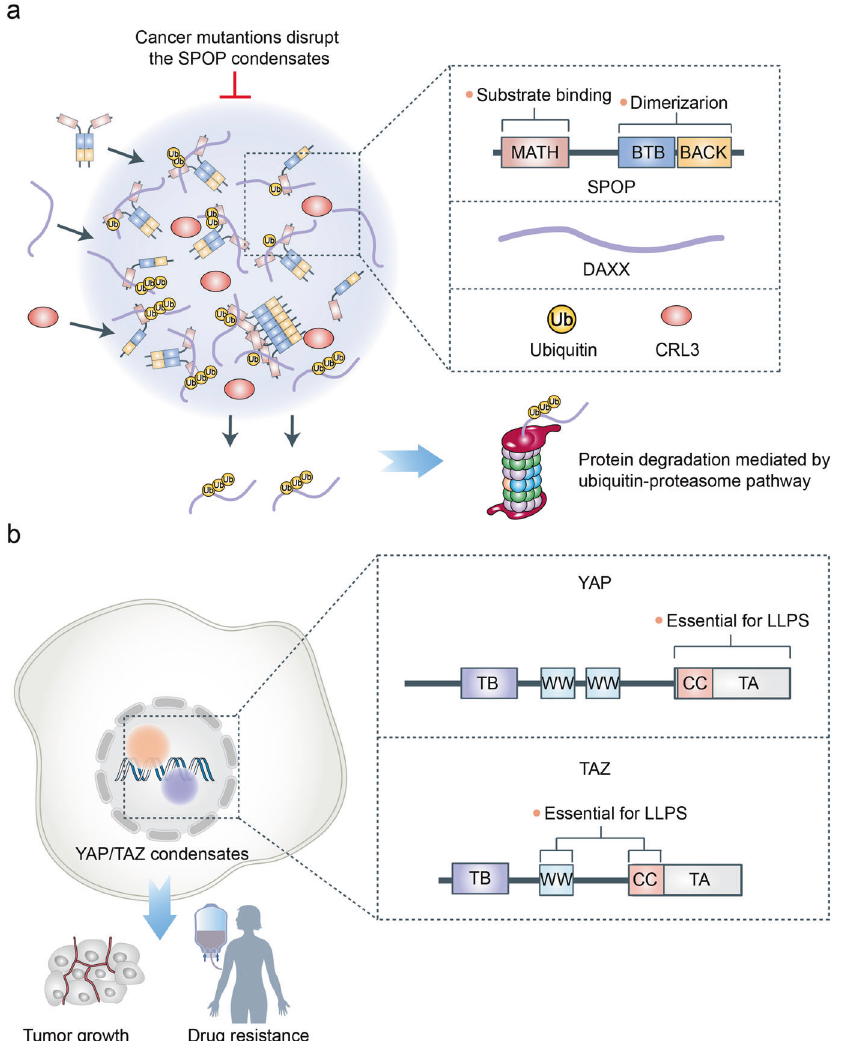
Fig. 8 LLPS in cancer. a Speckle-type POZ protein (SPOP) can phase-separate with its substrates and cullin3-RING ubiquitin ligase to form condensates, which promote the degradation of its substrates via the ubiquitin-proteasome system. SPOP consists of a substrate-binding meprin and TRAF homology (MATH) domain and two dimerization domains, BTB and BACK. The self-association by two dimerization domains and the multievent interactions between MATH domain and substrates are necessary for the phase separation of SPOP. Cancer-associated mutations in the MATH domain disrupt the formation of SPOP condensate by preventing the interaction between substrates and SPOP. b The transcriptional coactivators Yes-associated protein (YAP) and transcriptional coactivator with PDZ-binding motif (TAZ) can activate the transcription of various genes via LLPS. The Hippo signaling pathway can inhibit the formation of YAP/TAZ condensates. However, the Hippo signaling pathway is inactivated in many cancers. Therefore, the accumulation of TAZ and YAP can largely activate the transcription of proto- oncogenes via phase separation, promoting cell proliferation and anti-PD-1 immunotherapy resistance via LLPS. The intrinsically disordered TA and CC domains are essential for the formation of YAP condensates, whereas the CC and WW domains are vital for TAZ phase